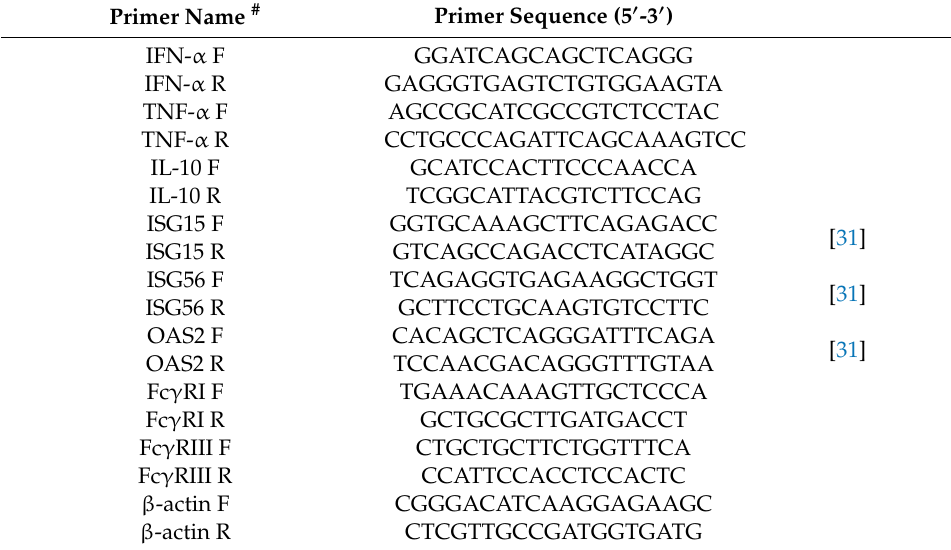
Table 2. Relative quantitative real-time polymerase chain reaction (RT-PCR) primers used in this